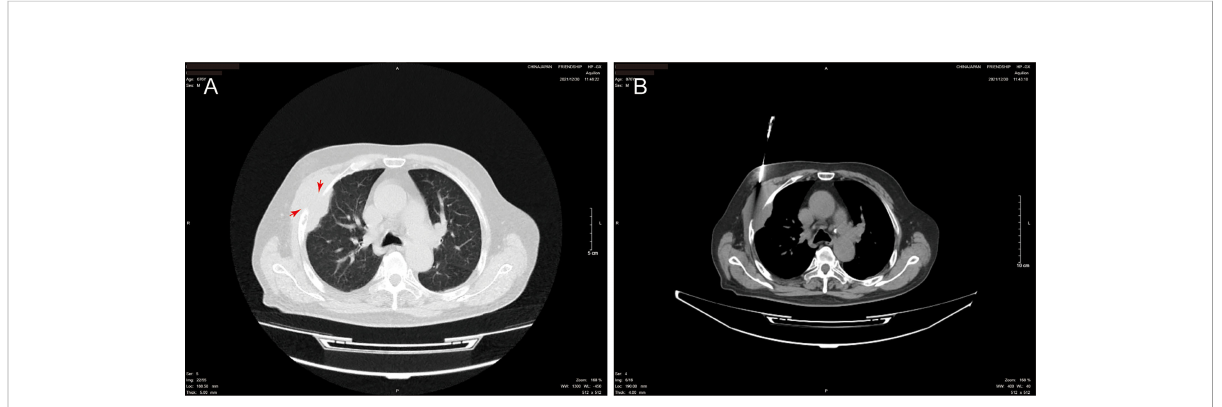
FIGURE 1 Chest computed tomography (CT) scans. (A) Pulmonary window showing the maximum cross-section of the mass (89 × 42 mm). The image shows the third and fourth ribs, which exhibit insect-like bone destruction; the adjacent pleura is thickened (red arrow). (B) Mediastinal window obtained under CT-guided core needle